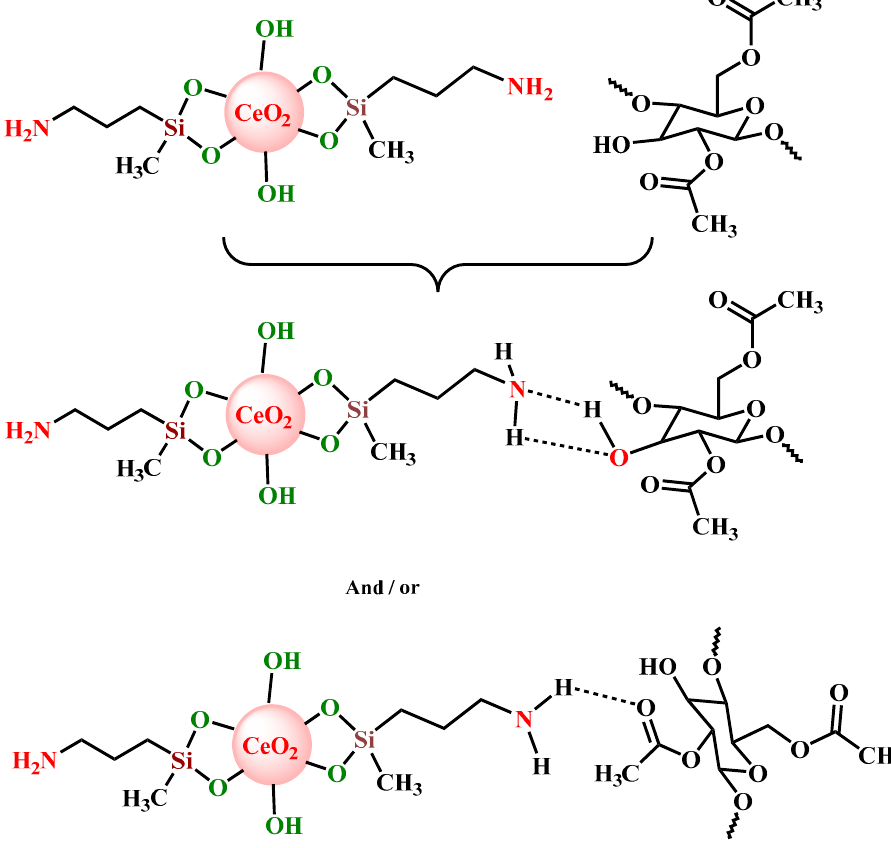
Figure 3. Possible interaction mechanism between CeO 2 –3-aminopropyl (diethoxy) methylsilane (APDMS) nanoparticles and cellulose acetate molecules.